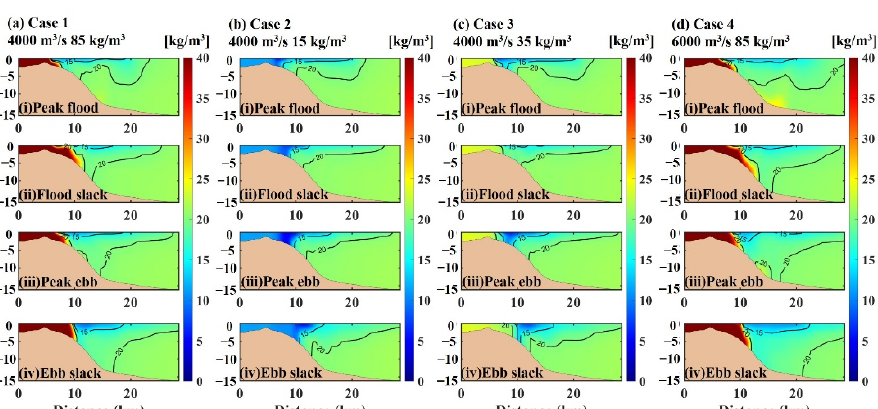
Figure 12. Vertical profiles of salinity along the axial section P1 at different times: Note that Figures 12a ‐ d represent Case 1 ‐ 4, respectively whereas ( i ) peak flood; ( ii ) flood slack; ( iii ) peak ebb; ( iv ) ebb slack. In Case 3, the initial condition of the sediment load at the open boundary of the river side was set to 35 kg/m 3 (see Table 2). As observed in Figure 10c, the excess bulk density